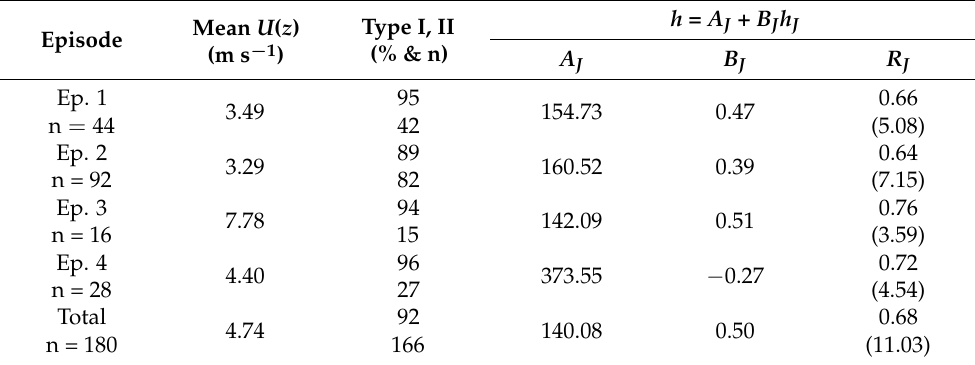
Figure 8. Time–height cross section of the 10 min wind profile maximum height h J , wind shear height Figure 8. Time – height cross section of the 10 min wind profile maximum height ℎ 𝐽 , wind shear height ℎ 1 , and calculated SBL height h from 4 – 7 August 2020. The heights of the maximum wind h 1 , and calculated SBL height h from 4–7 August 2020. The heights of the maximum wind profile h J are denoted by black plus signs, the wind shear heights h 1 are shown as red triangles, and the black circles with lines indicate the calculated SBL heights h . The four episodes (Ep. 1, Ep. 2, Ep. 3, and Ep. 4) are delineated by the brown background (same as Figure 2) and determined by β < 0.1. Table 2. Correlation coefficients ( R J ), slopes ( B J ), and biases ( A J ) for the linear regressions between h and h J . The regression data are separated for the four episodes (Ep. 1, Ep. 2, Ep. 3, and Ep. 4). The Z-test values are in